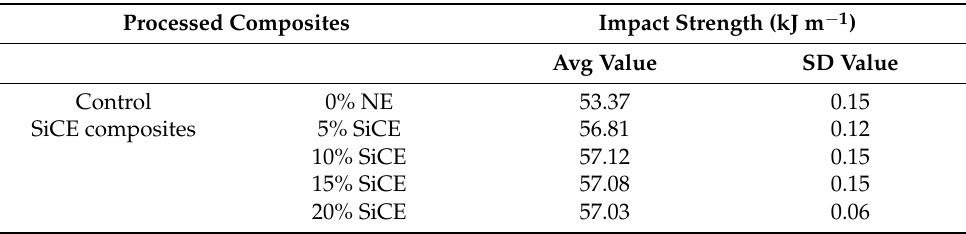
Table 3. Results of impact tests for all processed ceramic incorporated E-glass fiber reinforced epoxy